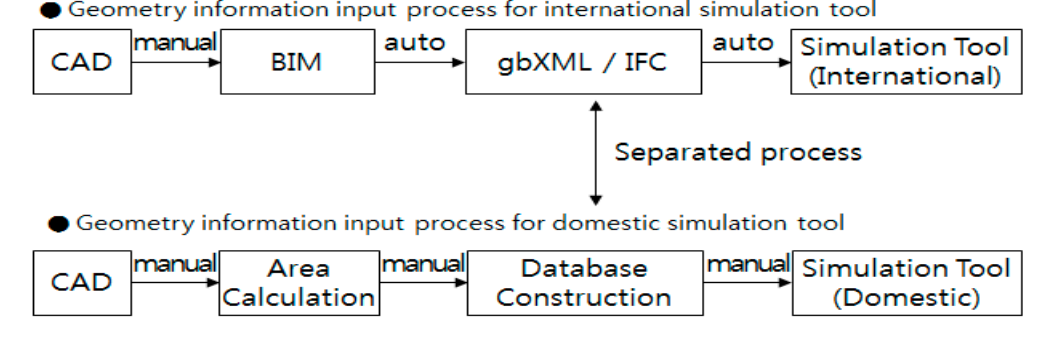
Figure 1. Separated process for different simulation.